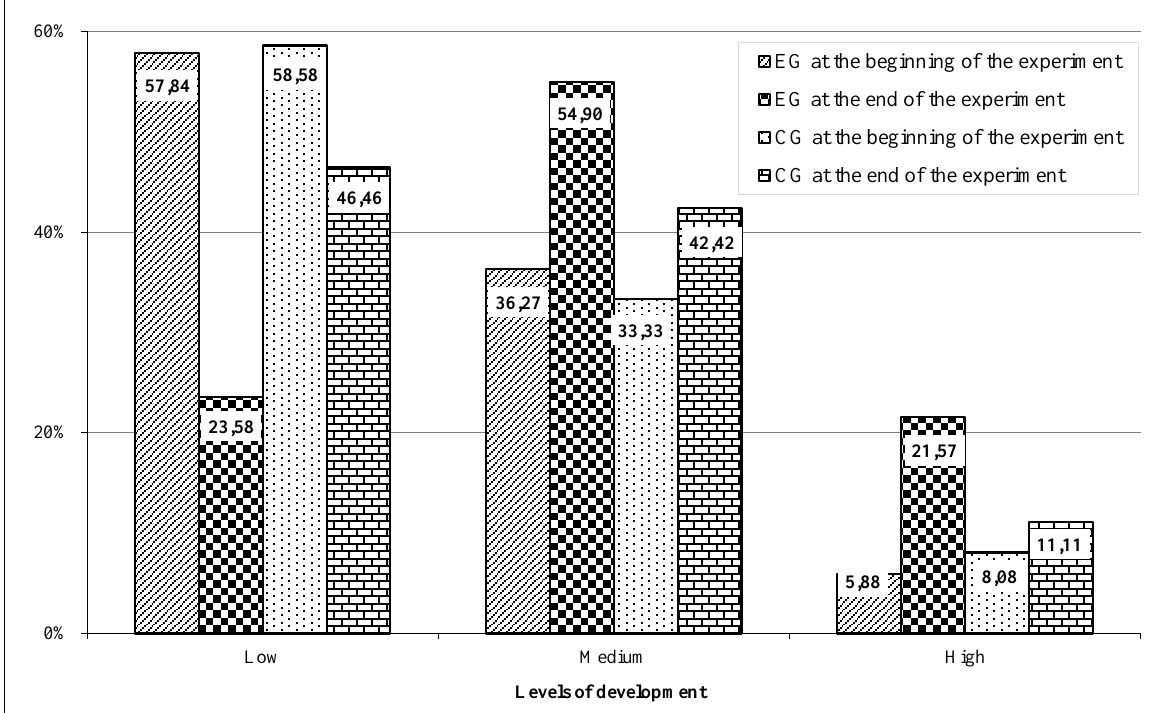
Figure 2. Results of the Forming Experiment on the Development of Foreign Language Activity Skills of Future Translators (based on Gender